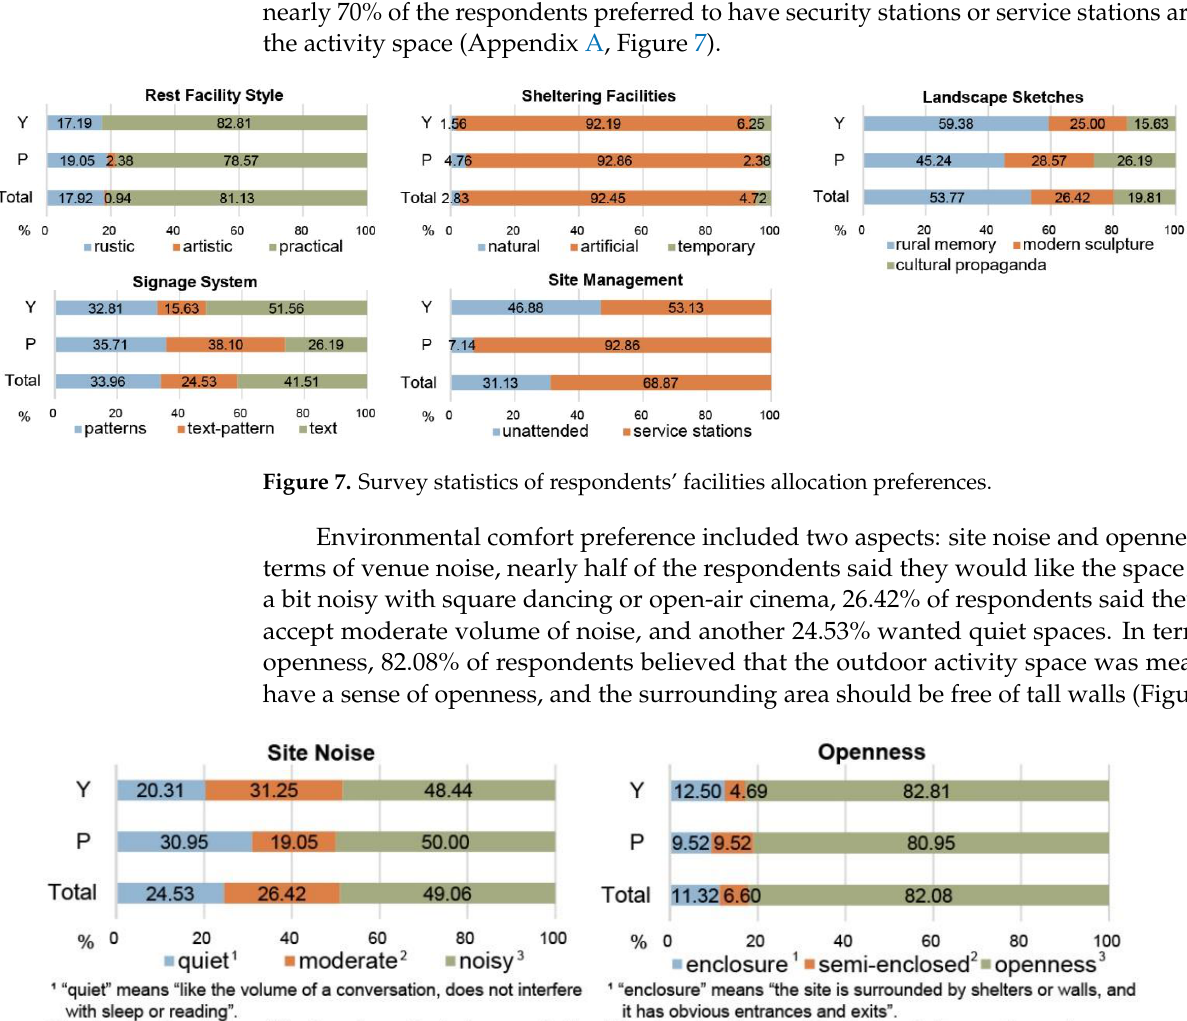
10 of 20 Figure 6. Survey statistics of respondents ’ landscape preferences.